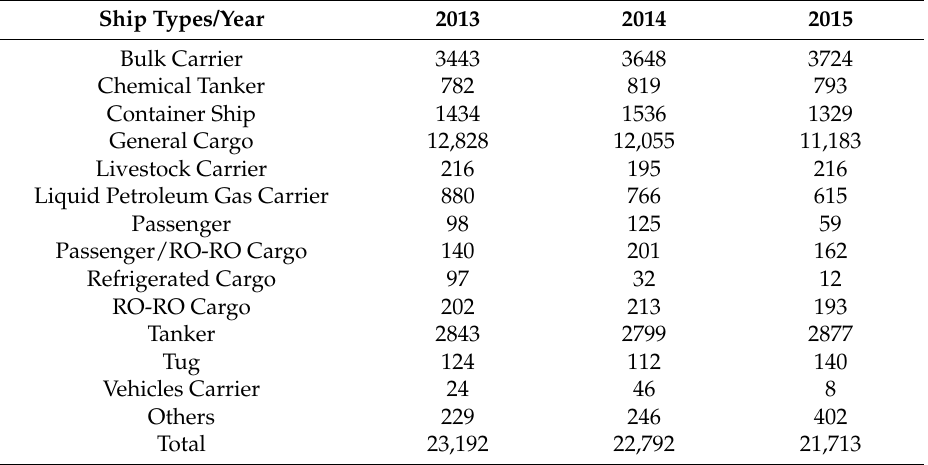
Table 4. Annual reports of the ships sailing to the Black Sea through Bosporus Strait.